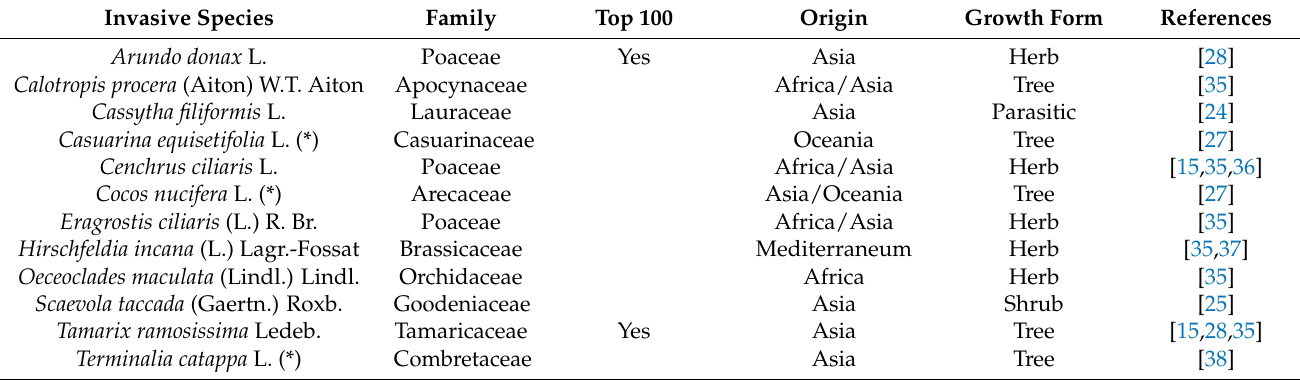
Table 3. List of exotic plants found on Mexican coastal dunes. Abundant and potentially invasive plants